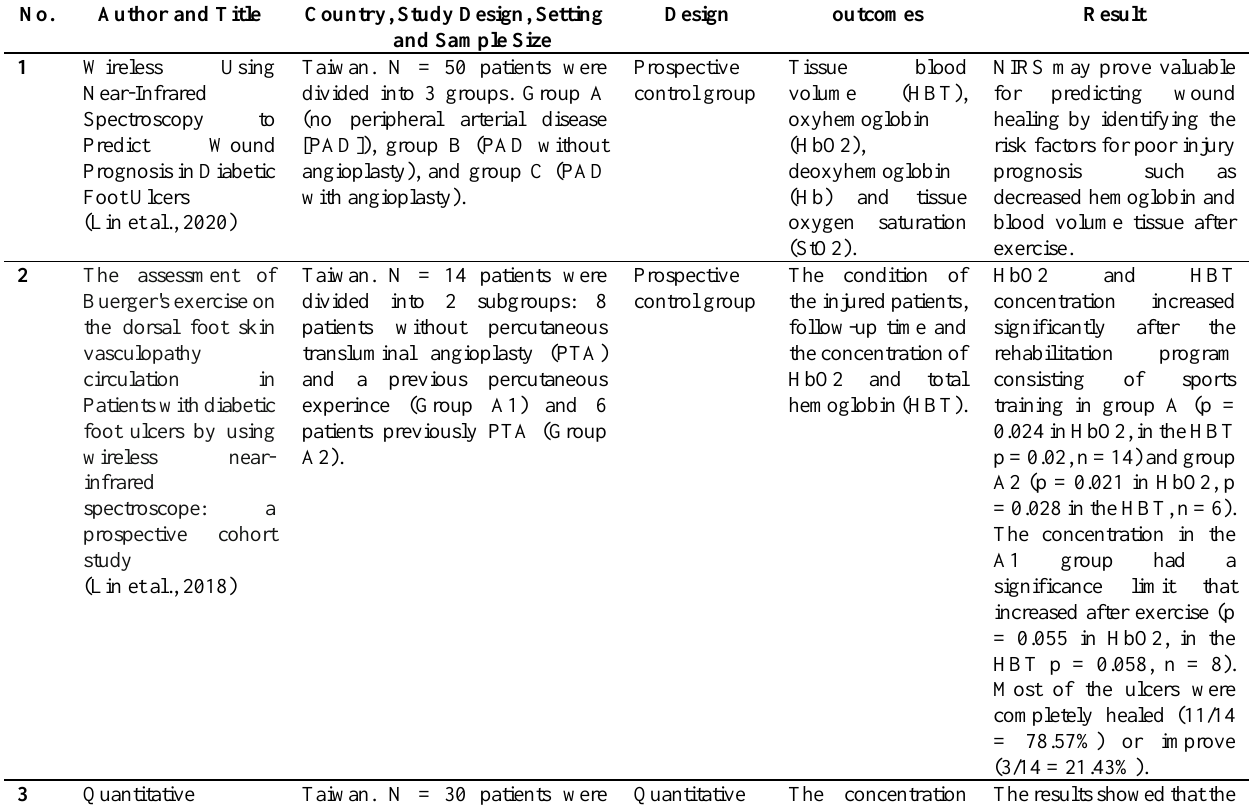
Table 1.Characteristics of the Main